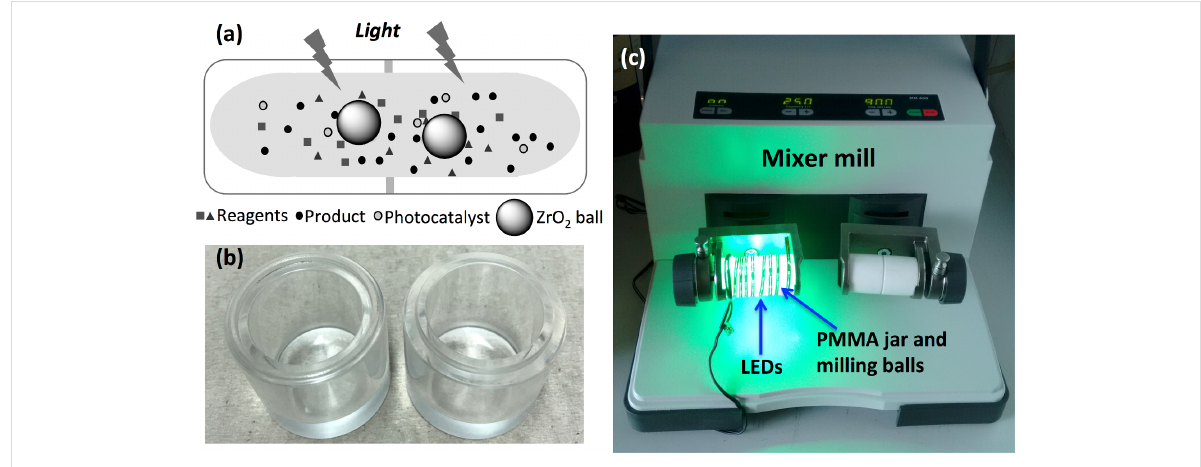
Figure 1: (a) Cartoon representing the merging of light and mechanical energy. (b) 25 mL transparent PMMA milling jar. (c) Experimental setup for si- multaneous photo- and mechanical-activation with an external light